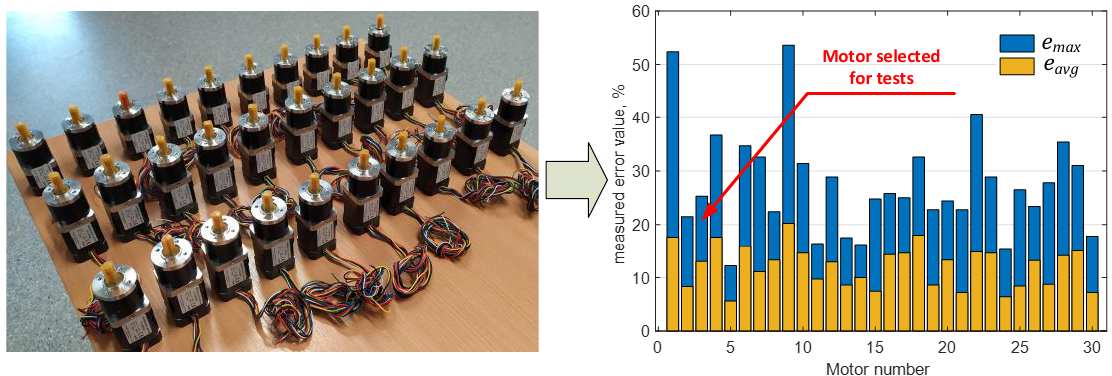
Figure 2. Distribution of errors in the position of sensors for BLDC motors from one production series. It is clearly seen that this problem is common, and that the sensors’ placement error value is significant with respect to the absolute values of the motor shaft position deter-